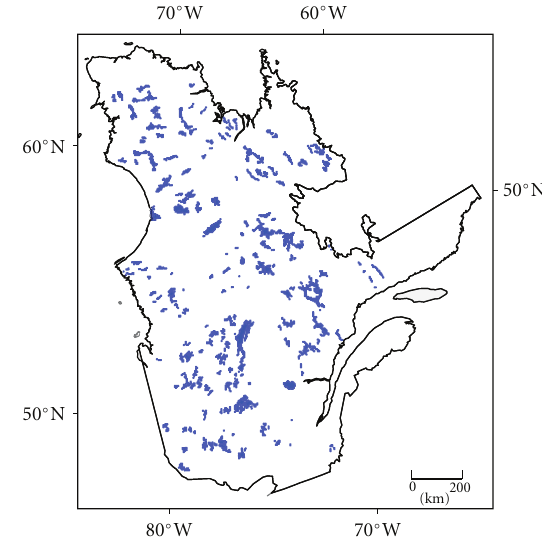
Figure 3: Lakes identified by both IMS and MODIS